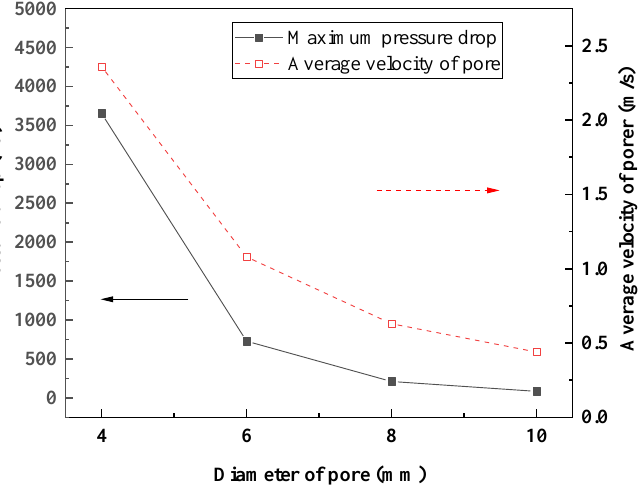
Figure 10. Maximum pressure drop within the water diffuser and the average velocity of perforated pores under different perforated pore diameters.